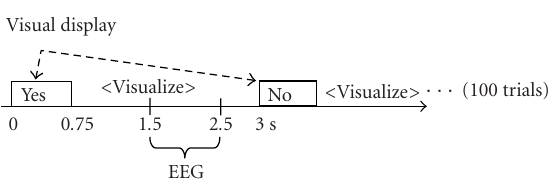
Figure 1: BCI task timeline. Subjects were asked to visualize the most recently presented word until the next word is displayed. The period of simultaneously recorded EEG used for subsequent anal- ysis was 1000 milliseconds long beginning 750 milliseconds after display o ff set and 500 milliseconds before the next display